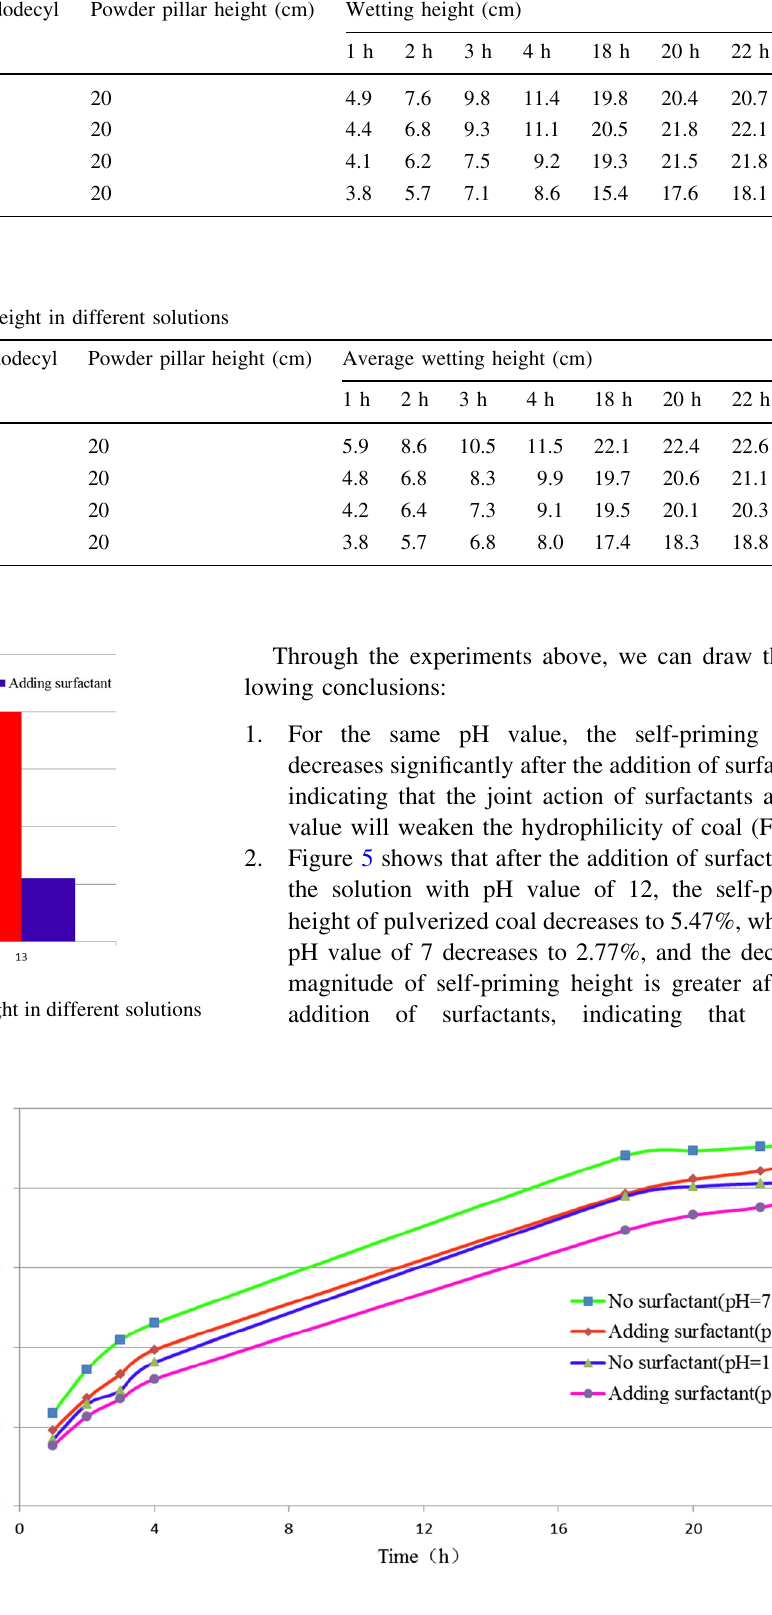
Table 5 Experimental results of pulverized coal’s self-priming in different solutions (the second group) Coal no.